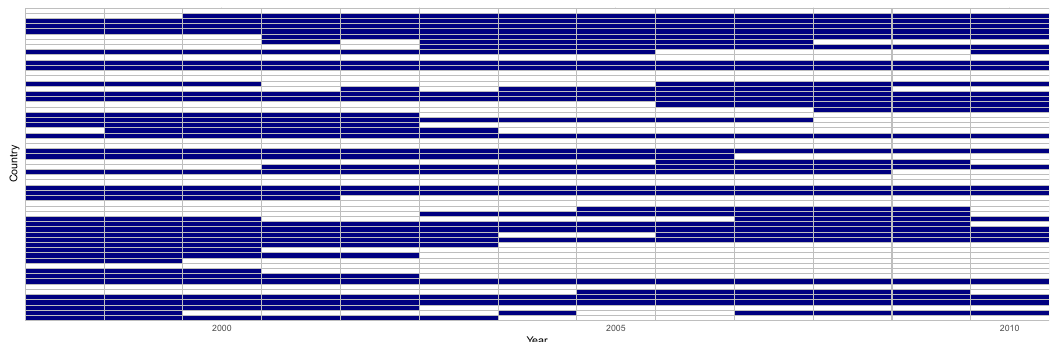
Figure 8: Blue tiles indicate when a country has had a negative or above 5% median in fl ation rate in the last 7 years while having legislated an independent central bank